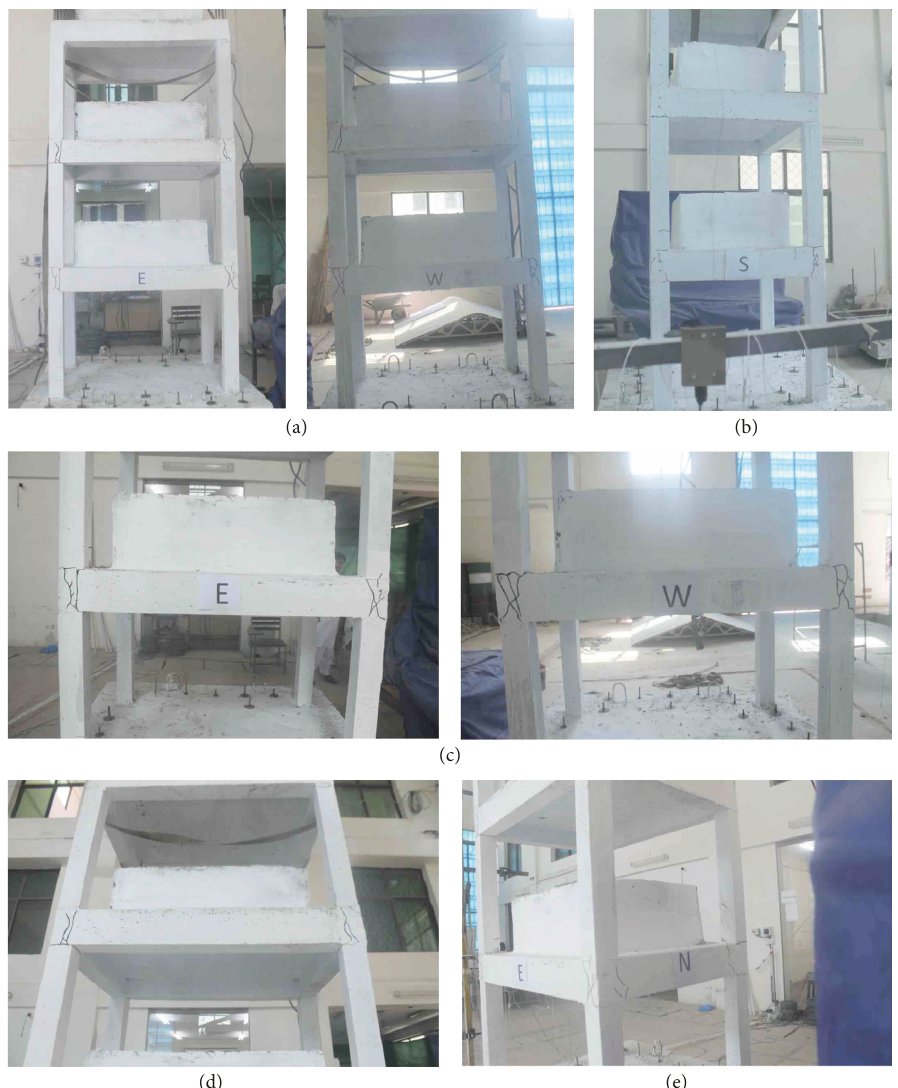
Figure 5: Damages observed in the frame structure under 200% earthquake motions. (a) In-plane loaded frame. (b) Face-loaded frame. (c) Damage to joints on first floor. (d) Damages observed in beams and joints at the second floor. (e) Damage pattern at